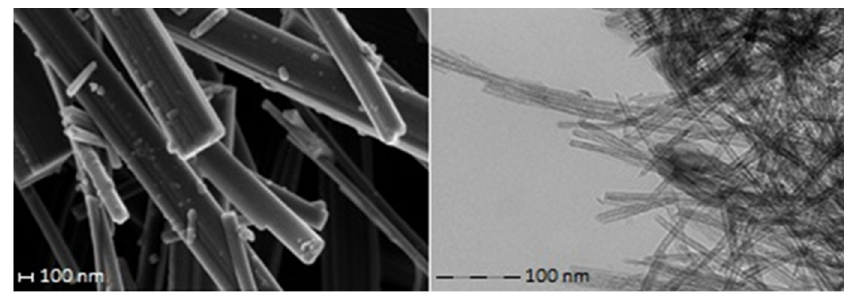
Figure 2. SEM (left) and TEM (right) images of synthesized nanotubes.